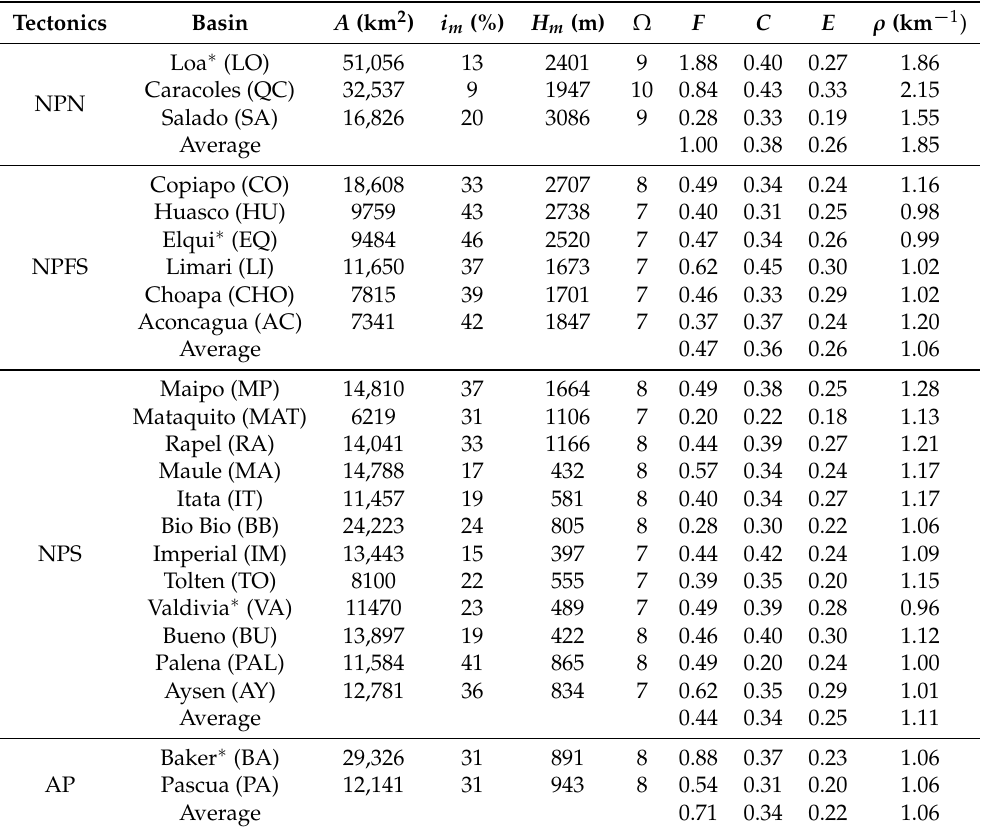
Table 1. Morphometric parameters of large basins sorted from north to south and by tectonics influence. ( NPN : Nazca plate-north, NPFS : Nazca plate-flat slab, NPS : Nazca plate-south, AP : Antarctic plate). Here A is the drainage area, i m the mean slope, H m the mean elevation of the unit and Ω the Strahler’s maximum order of each network ( ∗ Basins chosen for analysis at sub-basin